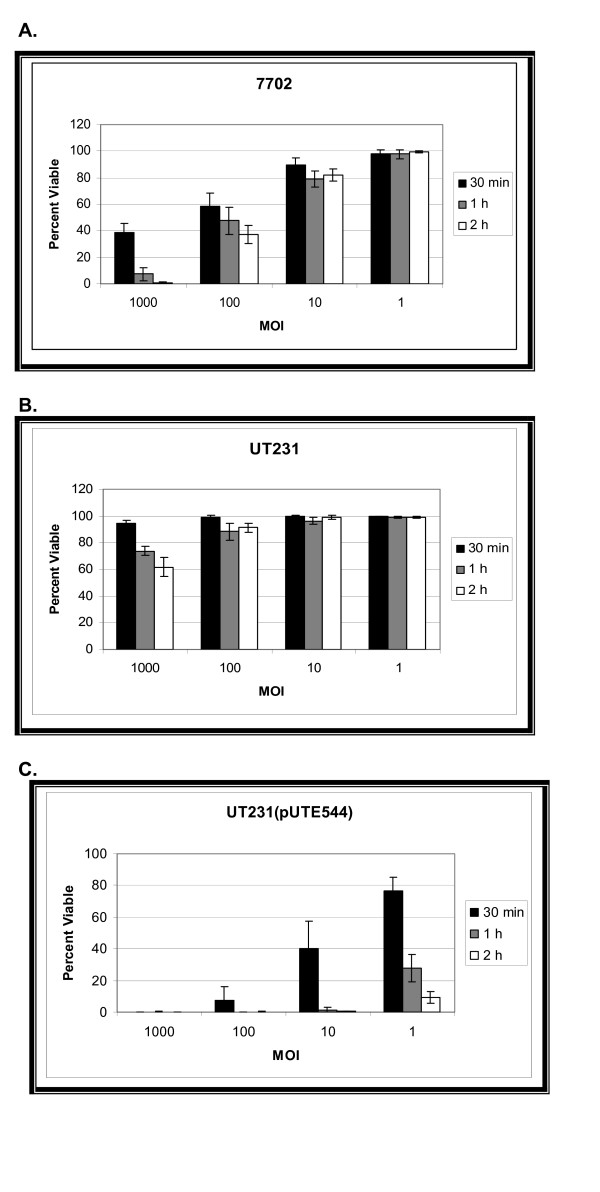
Bacillus anthracis strains secreting ALO lyse THP-1 monocytes in a dose and time dependent manner. Percent viable THP-1 s in the presence of B. anthracis Sterne strain (A.)7702 (ALO+), (B.) UT231 (ALO-) and (C.) the complemented over-producer, UT231 (pUTE544) (ALO++) at MOIs of 1000, 100, 10 and 1 in serum free conditions. At time points, aliquots were mixed with 0.25 % trypan blue. Results are average ± standard deviations of three experiments, each performed in duplicate. (MOI of 100, 30 min, 1 h, 2 h, p < 0.001,1 way ANOVA. p < 0.001 for UT231/7702, UT231/UT231 (pUTE544), 7702/UT231 (pUTE544), Tukey test. MOI of 10, 30 min, 1 h, 2 h, p < 0.001,1 way ANOVA. 30 min, p < 0.001 for UT231/UT231 (pUTE544) and 7702/UT231 (pUTE544), Tukey test. 1 h and 2 h, p < 0.001 for UT231/7702, UT231/UT231 (pUTE544), 7702/UT231 (pUTE544), Tukey test.